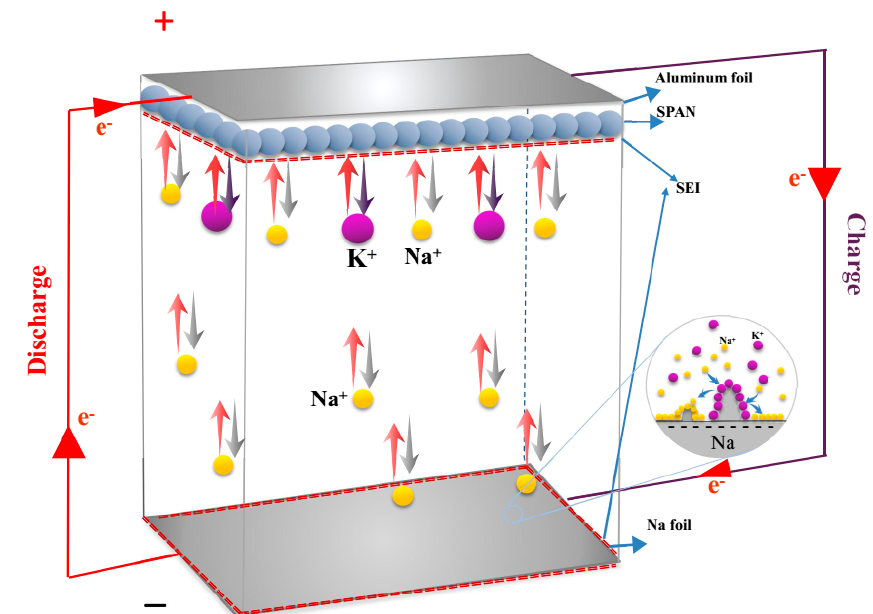
Figure 3. ( a ) Schematic diagram of the redox reaction in the hybrid Na + /K + battery configuration. SEI, solid electrolyte interface. SEI, solid electrolyte